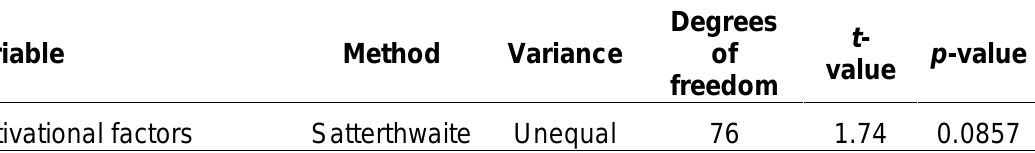
Table 8: Significant Differences Relating to